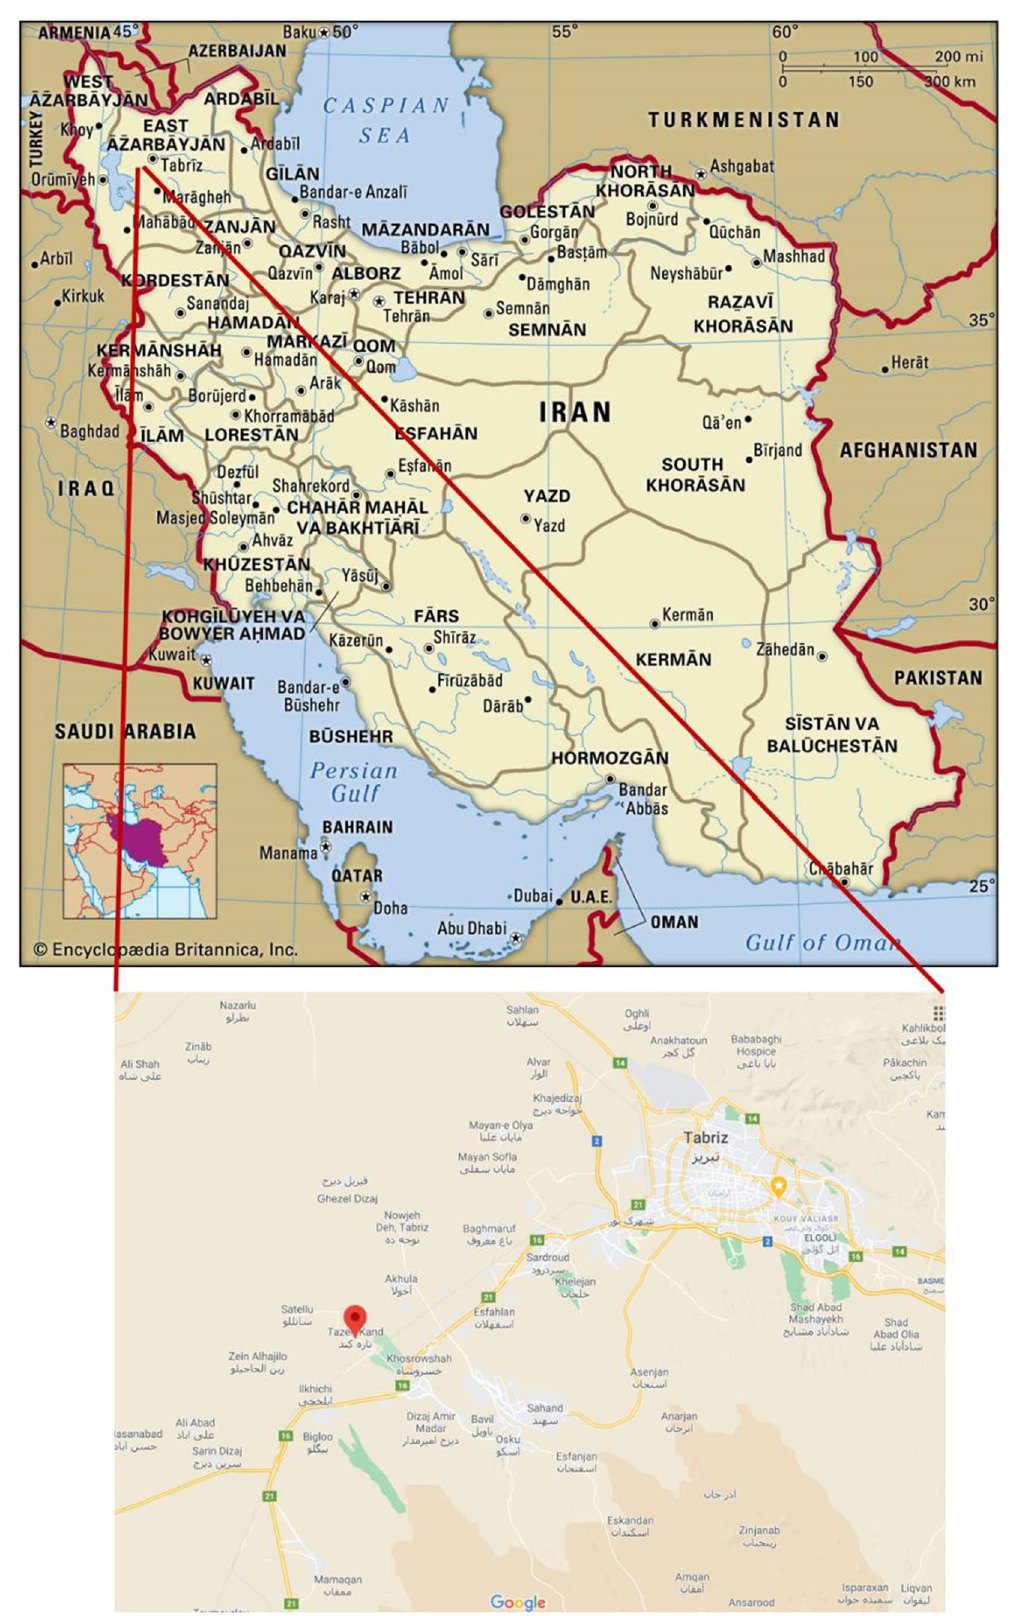
Fig. 1 Location of the test site in the Tazeh Kand village near Tabriz,